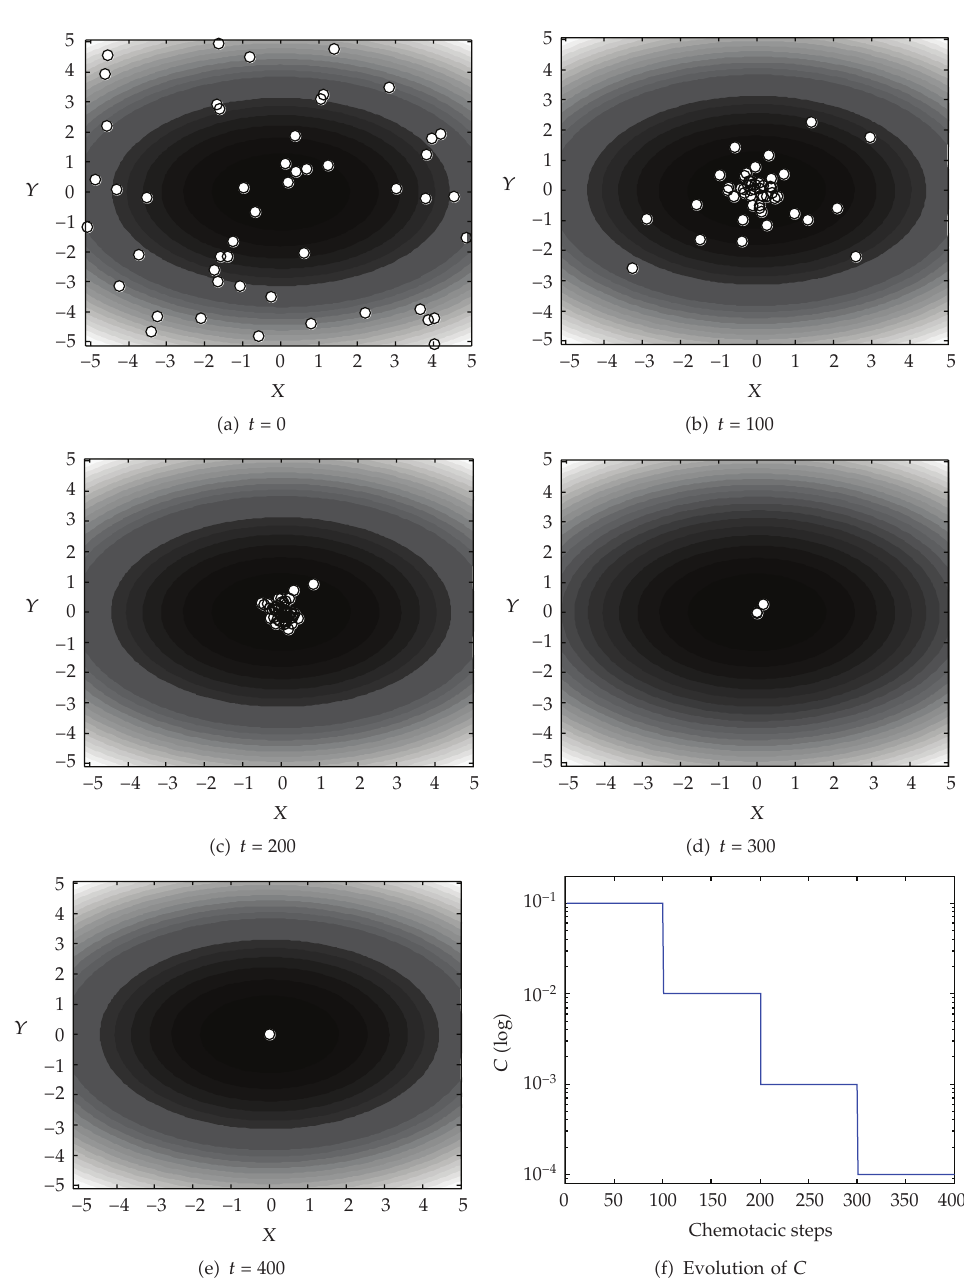
Figure 5: Population evolution of CBFO on 2D Sphere function in 400 chemotactic